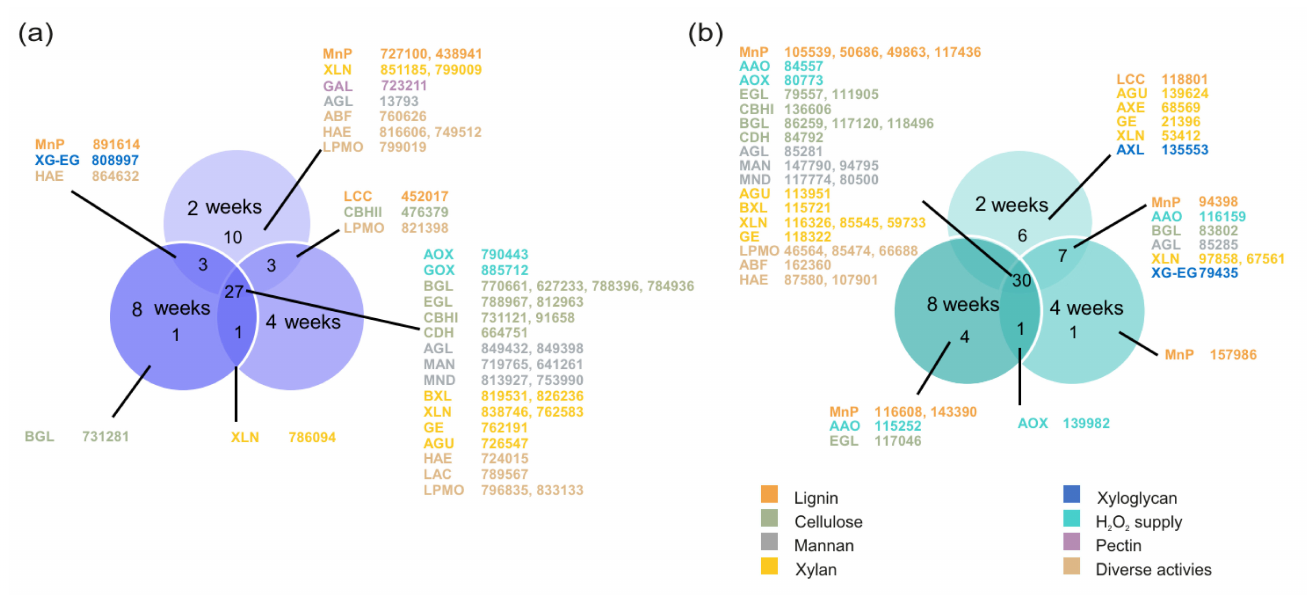
Figure 2. Venn diagrams showing the unique and common plant cell wall acting CAZymes in 2-, 4-, and 8-week solid spruce wood cultivations of ( a ) O. rivulosa and ( b ) G. subvermispora . CAZyme abbreviations (see Supplementary Table S1a,d) followed by JGI Protein IDs are depicted, and their font color is according to the substrate they are putatively acting